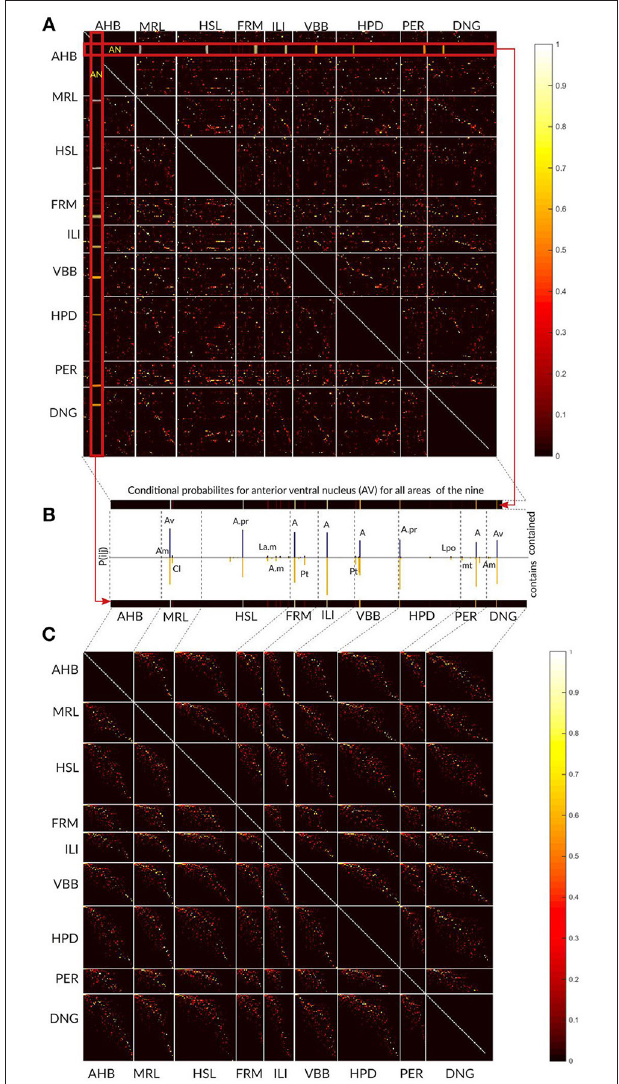
FIGURE 9 | Local area level concordance analysis of the nine atlases shown as image representing the non-symmetric concordance matrix P. (A) Each pixel in the image specifies the Pij value by its color. The Pij value expresses the probability of a voxel for being in area i in one atlas given that it is in area j in other atlas. Each row and column represent one specific area in an atlas. Areas belonging to an atlas are grouped together and the borders between the atlases are denoted by white lines inducing the appearance of the rectangular blocks in the image. (B) Here we show for the anterior ventral nucleus (AV) area from Atlas of the Human Brain how the values in the matrix should be interpreted. The row and column in the matrix that correspond to the AV values (red zoomed rectangles) are displayed as the bars. The color of the pixels in the row and the column (from yellow to red) determines the height of the bars in the plot (see the color bar on the right). The blue bars specify the proportion of AV comprised in other regions, and the yellow bars (below) indicate the proportion of other regions comprised in the AV region. The labels above the bars correspond to the significantly overlapping regions from the other atlases. (C) The matrix is shown after modifying the order of the areas independently within each block. The non-zero P ij values form a pixel cloud centered around the diagonal of the block. The brightness of this cloud shows the level of correspondence between the atlases and the width of the cloud approximates the frequency of the subdivision configurations between the